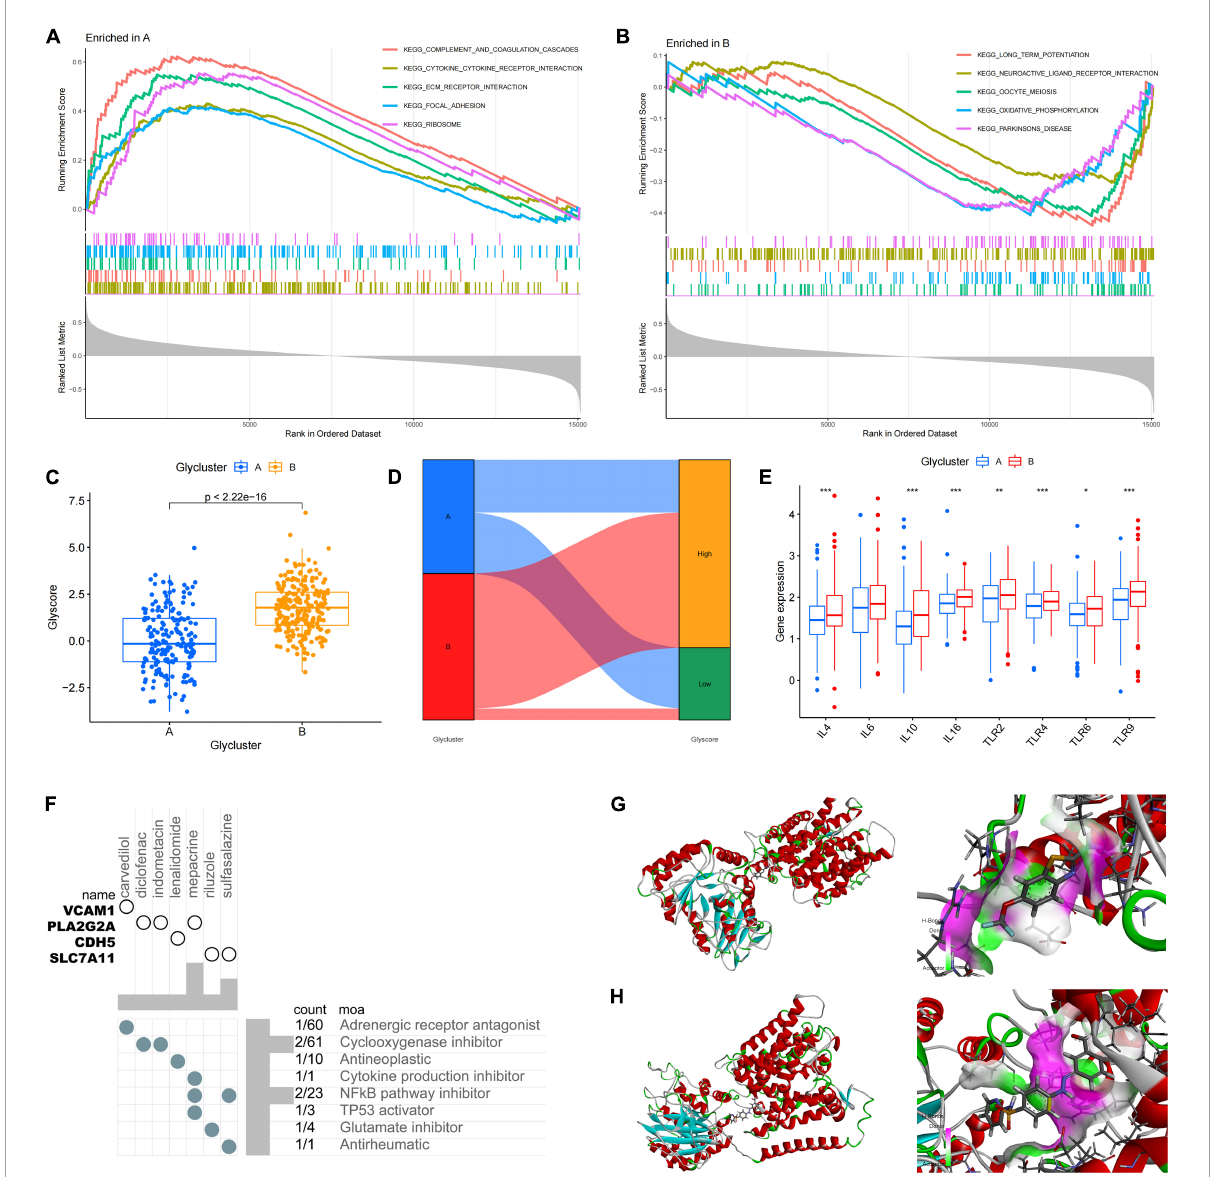
FIGURE3 Differences in protein glycosylation levels, neuroinflammation, and drug prediction between the subtypes. (A,B) GSEA analysis of subtypes A and B. (C) The difference in glycosylation level between the subtypes. (D) The distribution proportion of protein glycosylation level in each subtype. (E) Differences in expression levels of cytokines and inflammatory signal transduction molecules between the subtypes. * P < 0.05, ** P < 0.01, and *** P < 0.001. (F) The correlation between potential therapeutic drugs and corresponding targets. (G) The binding conformation of SLC7A11 and riluzole (binding energy = –7.8 kcal/mol). (H) The binding conformation of SLC7A11 and sulfasalazine (binding energy = –94.0